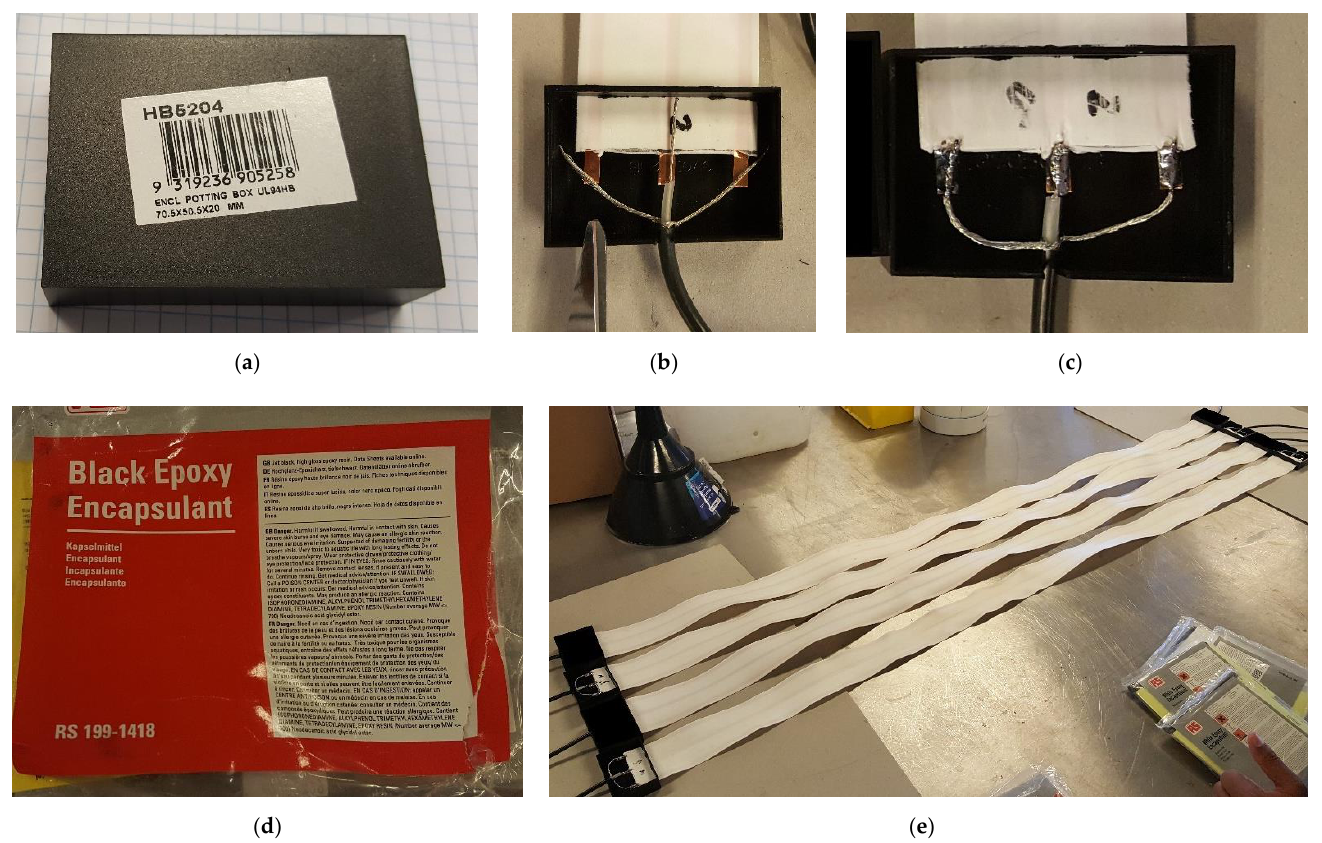
Figure 12. The flat ribbon cable (FRC) sensor manufacture: ( a ) the black terminal box for sealing connections between a coaxial cable and an FRC; ( b ) a demo of the wire configuration between two cables; ( c ) a demo of the coaxial cable soldered to copper wires in the FRC; ( d ) the black epoxy encapsulant applied to seal the terminal box; ( e ) a demo of finished sensors compared to unfinished ones.